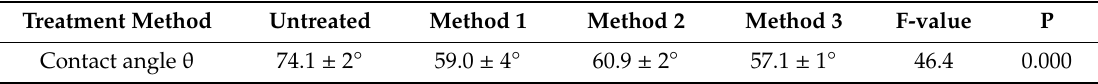
Table 5. Contact angle of four kinds of lu ff